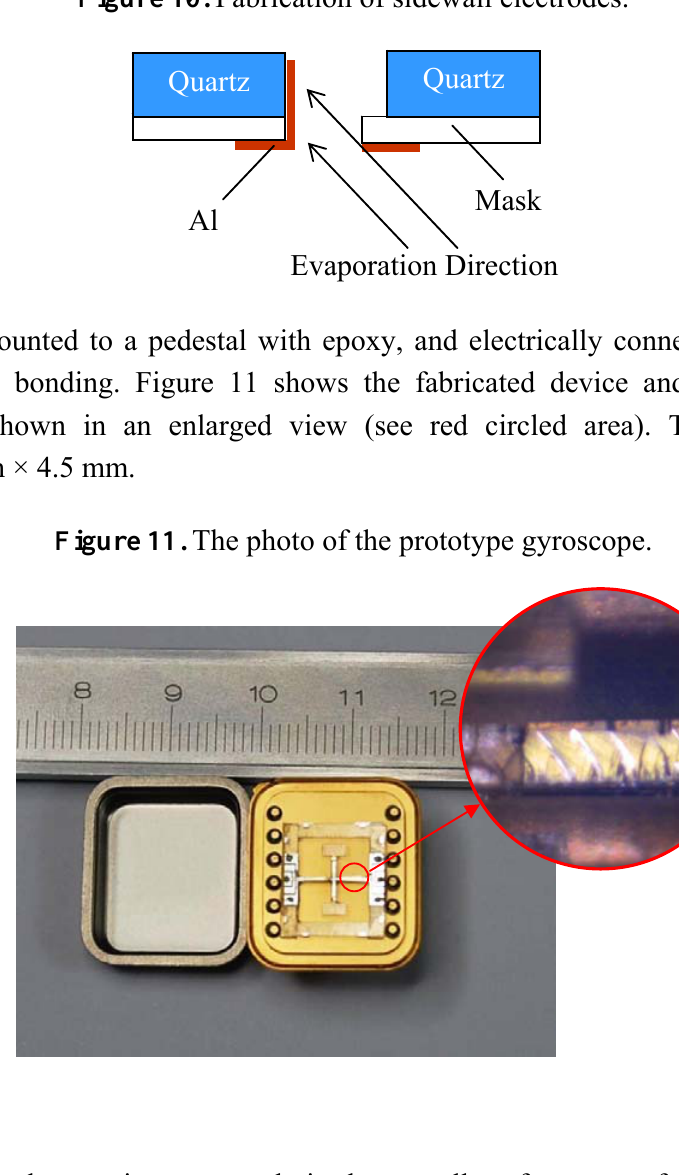
Figure 10. Fabrication of sidewall electrodes.